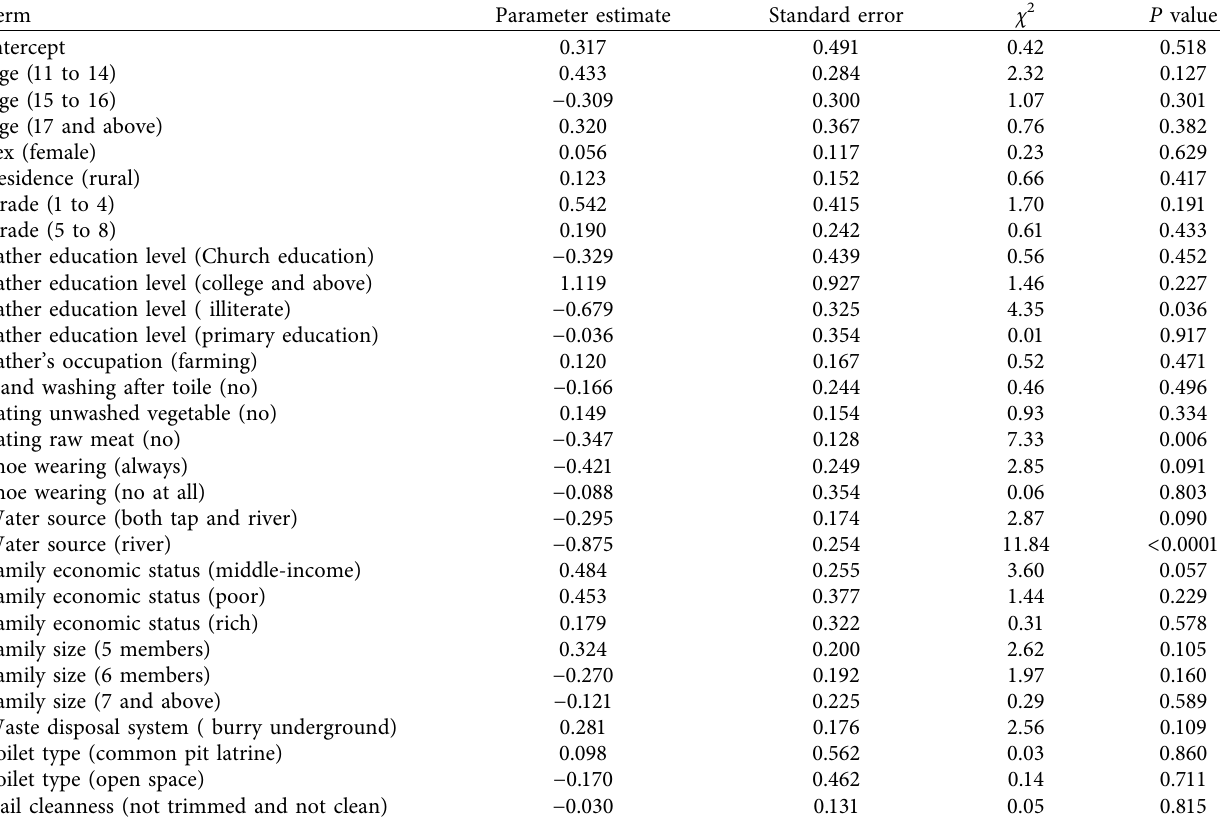
Table 3: Relationship between intestinal protozoan parasitic infections and explanatory variables among school children in Jaragedo town, South Gondar Zone, Ethiopia.